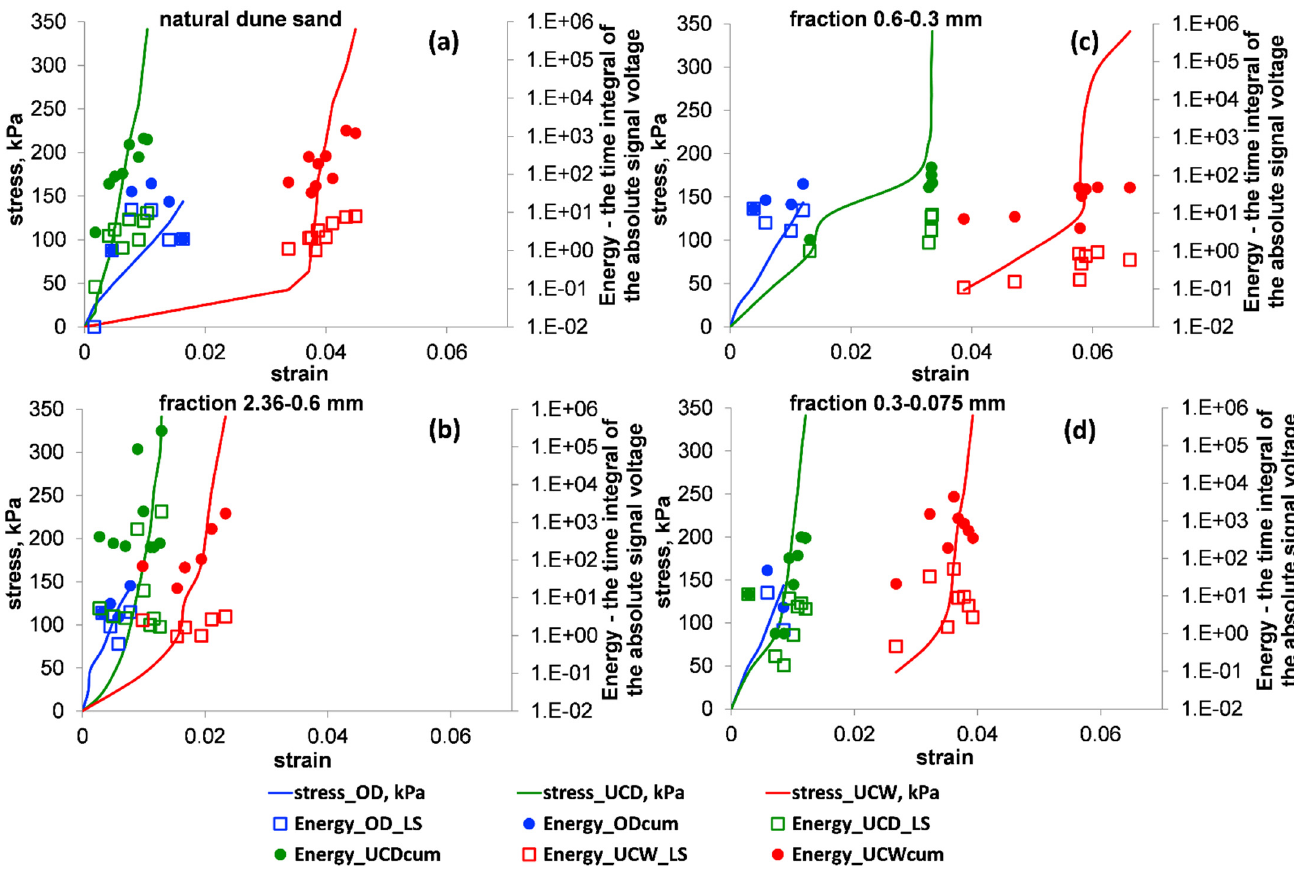
Figure 10. The stress–strain relationships (solid curves) vs. the energy values for the OD (blue), UCD (green) and UCW (red) tests. The empty squares and the full circles denote the values of the average (index = LS) and cumulative (index = cum) energy for a loading stage, respectively. Panels ( a – d ) illustrate the results for natural dune sand and its three extracted fractions: 2.36–0.6, 0.6–0.3, and 0.3–0.075 mm, respectively. Note that in the used number format, the notation “E ± xx” is part of a scientific notation and corresponds to “ · 10 ± xx